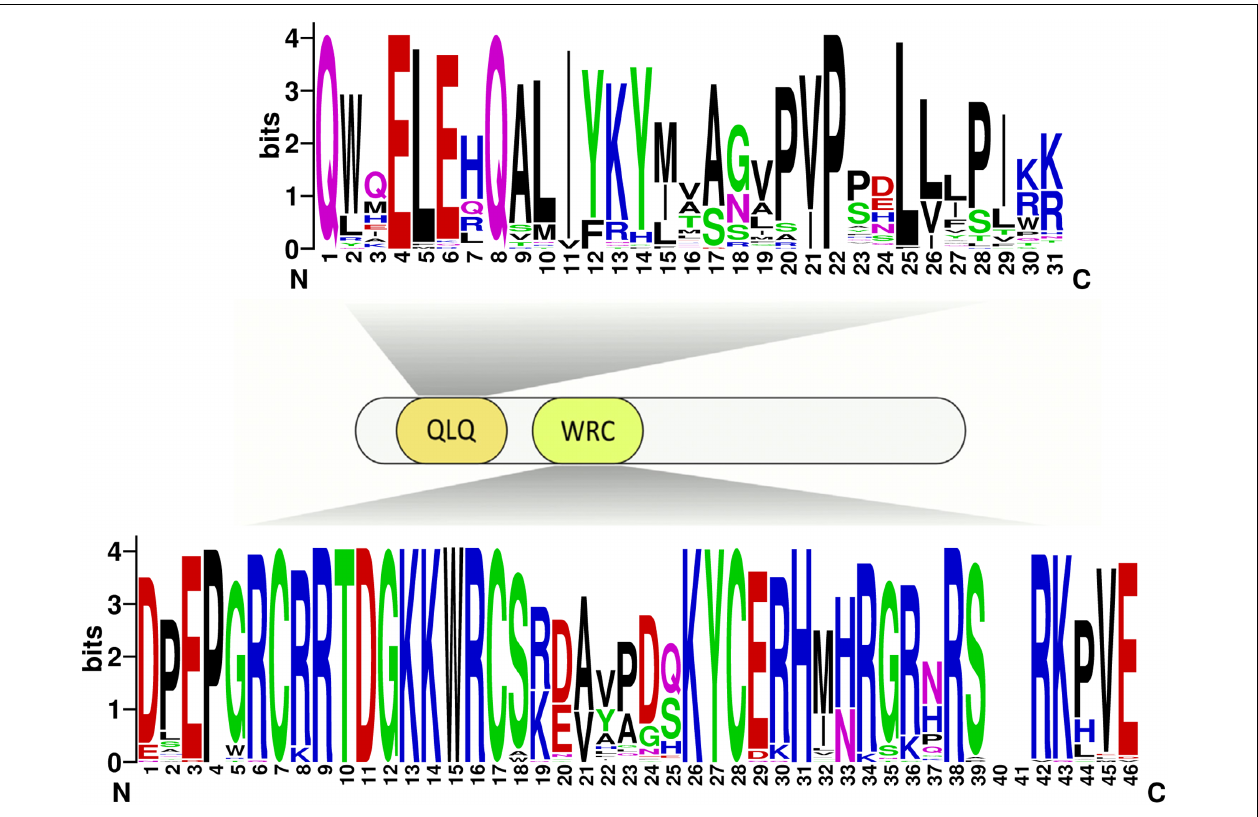
FIGURE 4 | Domain composition of GRFs. Fifty-eight GRFs have both the characteristic WRC and QLQ domains. The sequences of the QLQ and WRC domains of the 58 GRFs were aligned using ClustalW software to analyze their sequence features. These domain diagrams were plotted using the online WebLogo